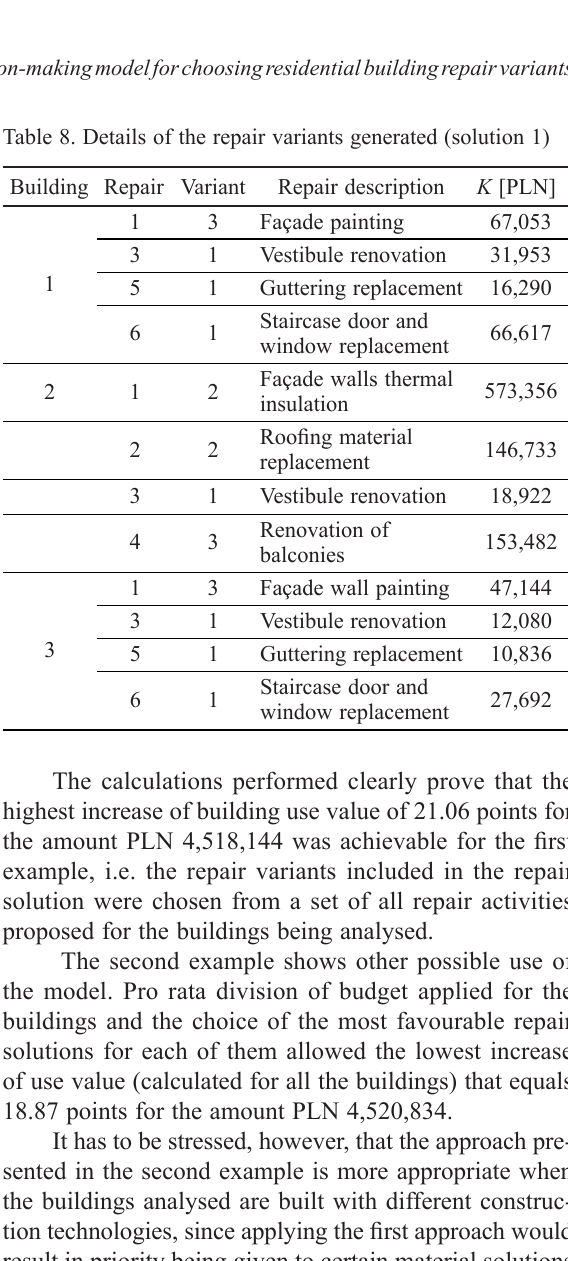
Table 6. Five best repair solutions